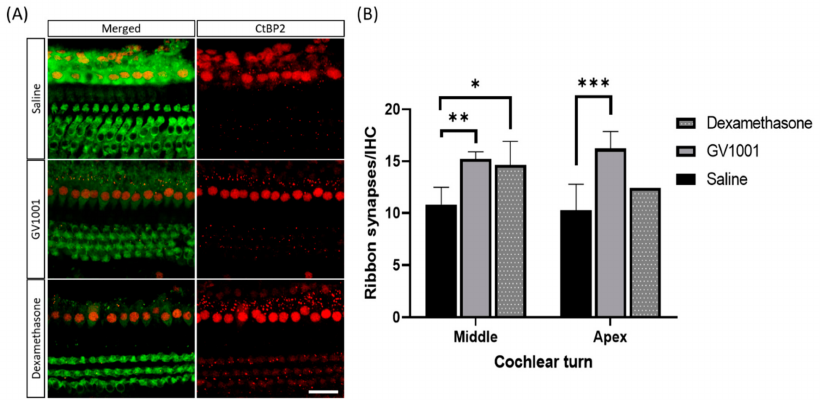
Figure 4. E ff ect of GV1001, dexamethasone, and saline on ribbon synapses. ( A ) Representative images of CtBP2-labeled ribbon synapses in cochlear apical turns 14 days after severe PTS-noise exposure. Scale bar: 10 µ m. Representative images were taken from the middle turn. ( B ) Error bars indicate the SEMs. Significant di ff erences are evident between the saline, and GV1001 and dexamethasone groups. All groups contained 4 mice ( n = 8 ears). * p < 0.05, ** p < 0.005, *** p < 0.001 (by the Kruskal–Wallis test and Mann–Whitney U-test). Scale bar, 10 µ m.